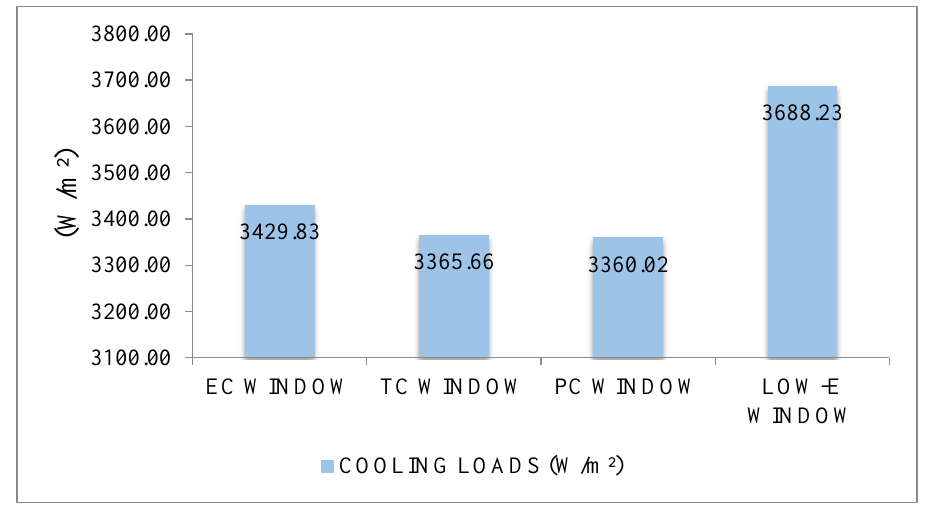
Figure 8 Total cooling loads of the windows for August 14 in Kayseri.